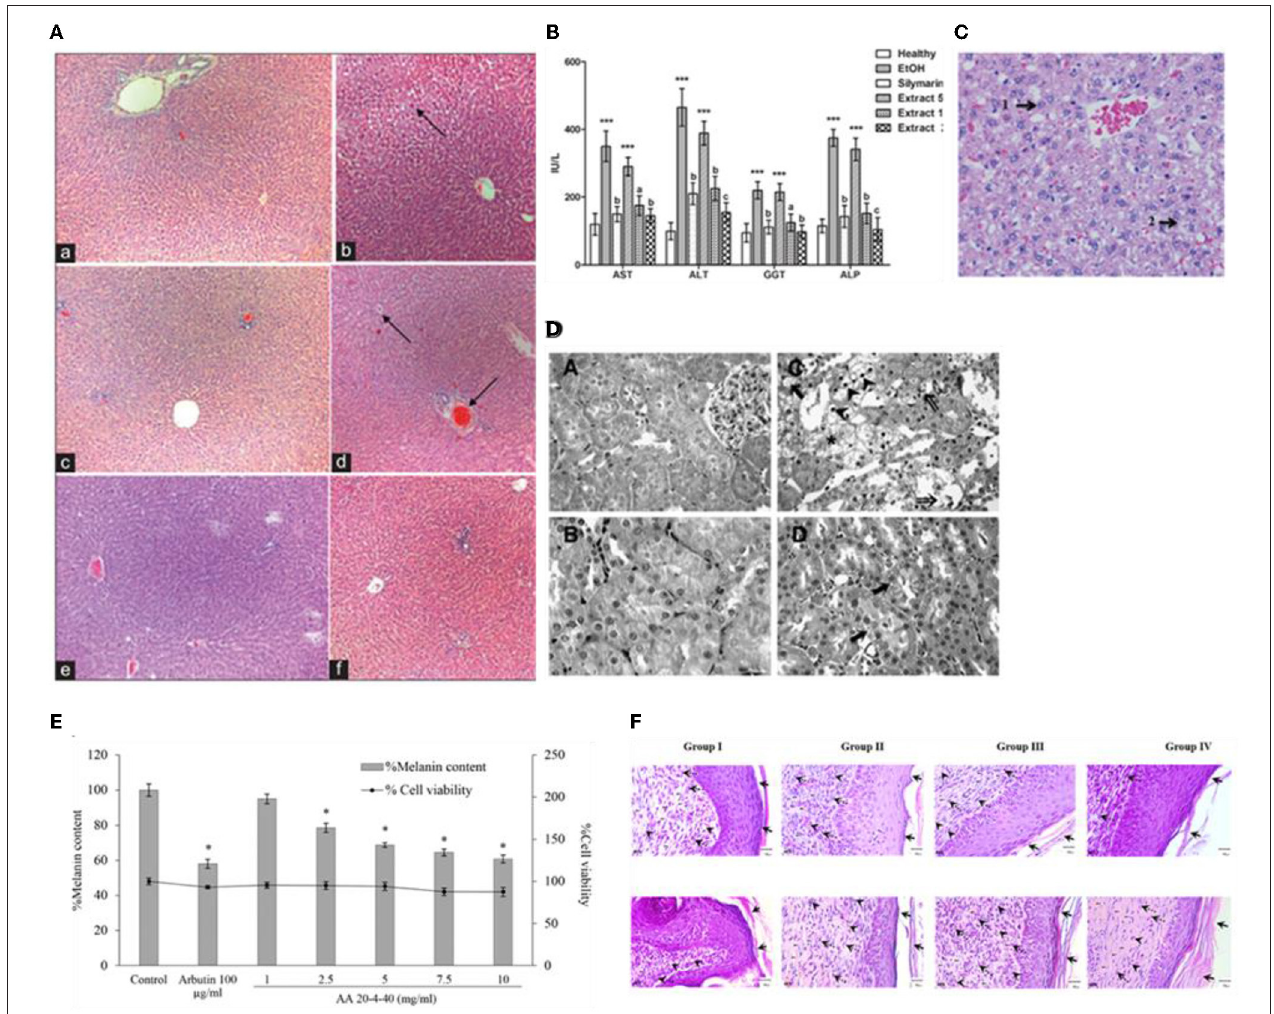
FIGURE 4 | Protective effects of shallot extracts on liver. (A) Histological changes in the liver of representative rats of each group (H and E, × 100). (a) Normal control group; (b) hyperuricemic control group; (c) hyperuricemic + 5 mg/kg/day allopurinol; (d) hyperuricemic + 3.5 g/kg/day shallot juice; (e) hyperuricemic + 7.0 g/kg/day shallot juice: (f) hyperuricemic + 10.5 g/kg/day onion juice ( 110). (B) Effect of aqueous crude extract of A. ascalonicum bulbs on ethanol-induced liver injury in mice. Groups of mice were administered with 50% (v/v) ethanol for 14 consecutive days followed by treatment with silymarin (10 mg/kg), and extracts (50, 100, and